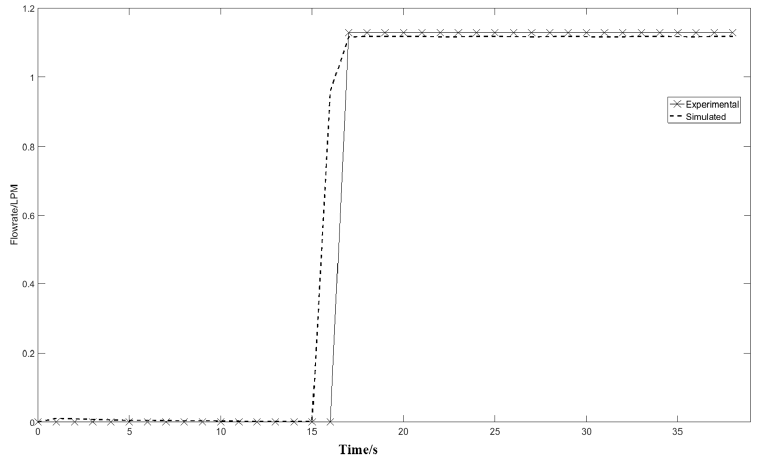
Figure 11. Comparison of the experimental and simulation results of the column outlet flow rate.